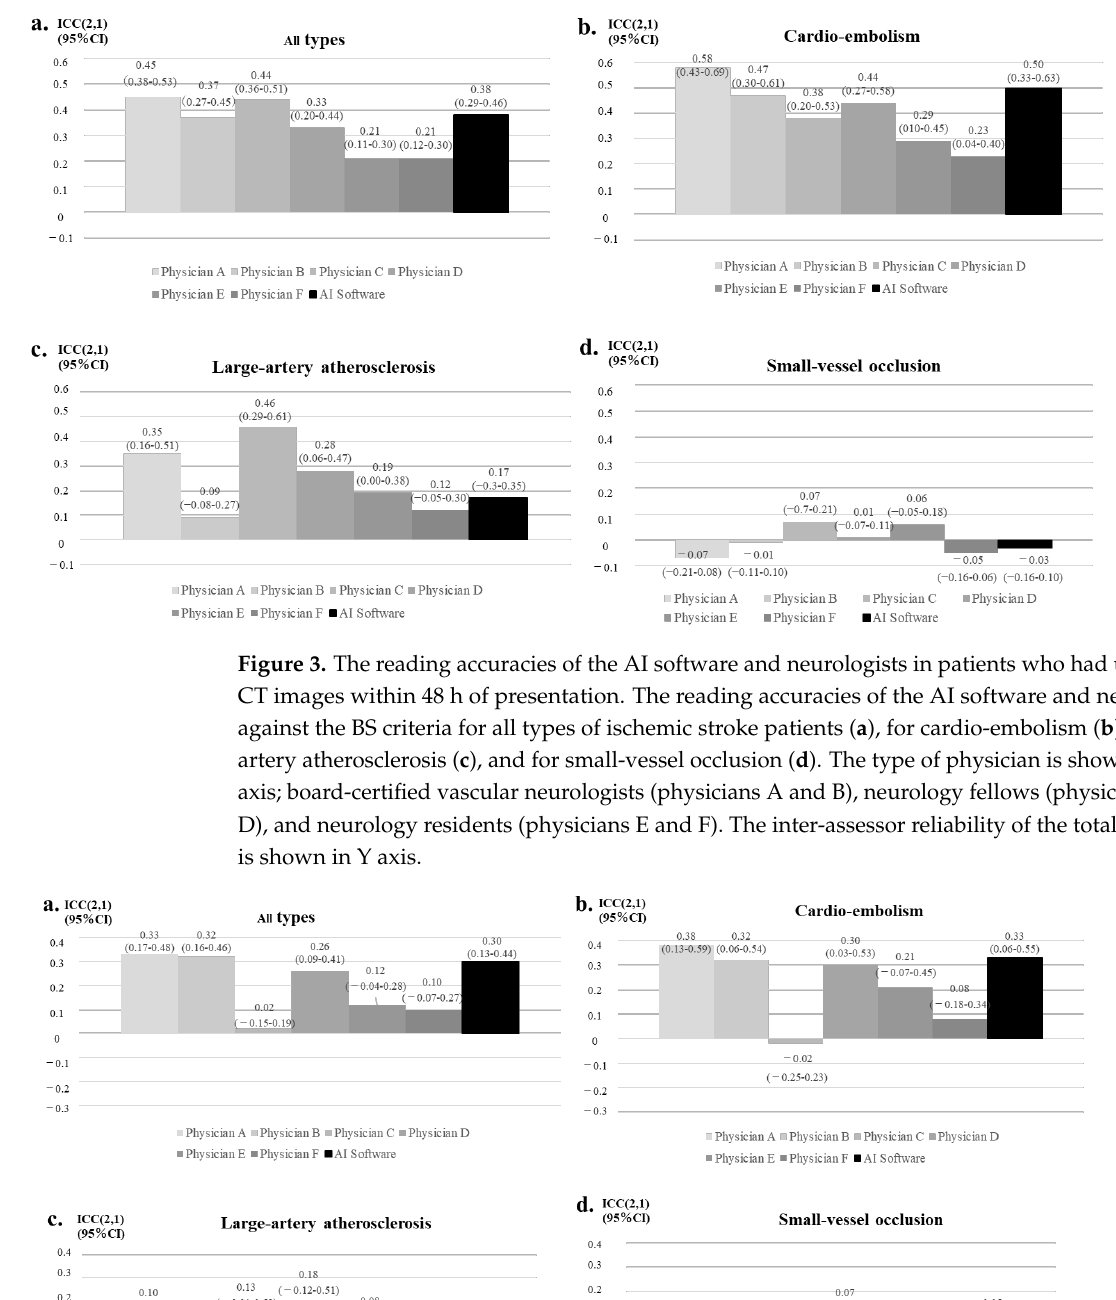
Table 2. Sensitivity and specificity of physicians and the AI software. Accuracy